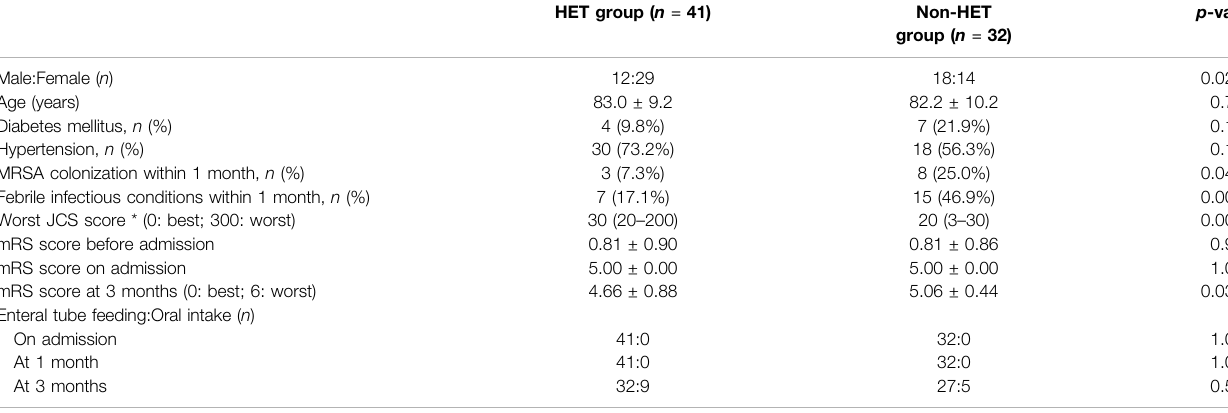
TABLE 1 | Demographic and clinical characteristics of the patients in HET and non-HET groups.